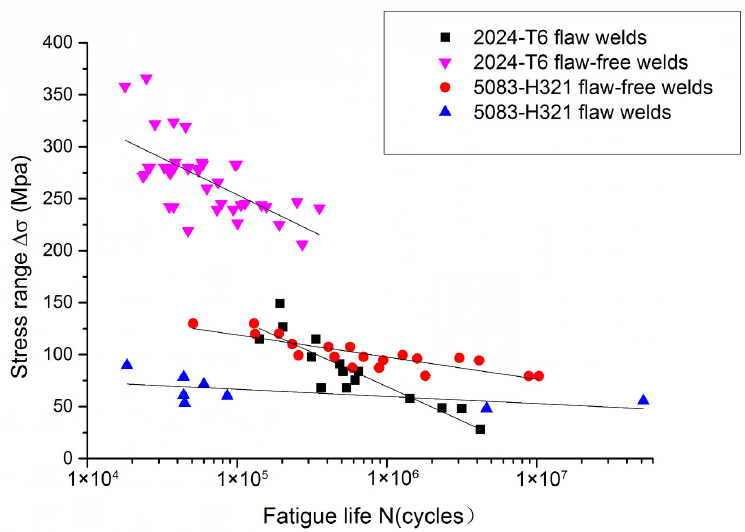
Figure 9. Effect of kissing bond on material fatigue properties [70,71,77,78].